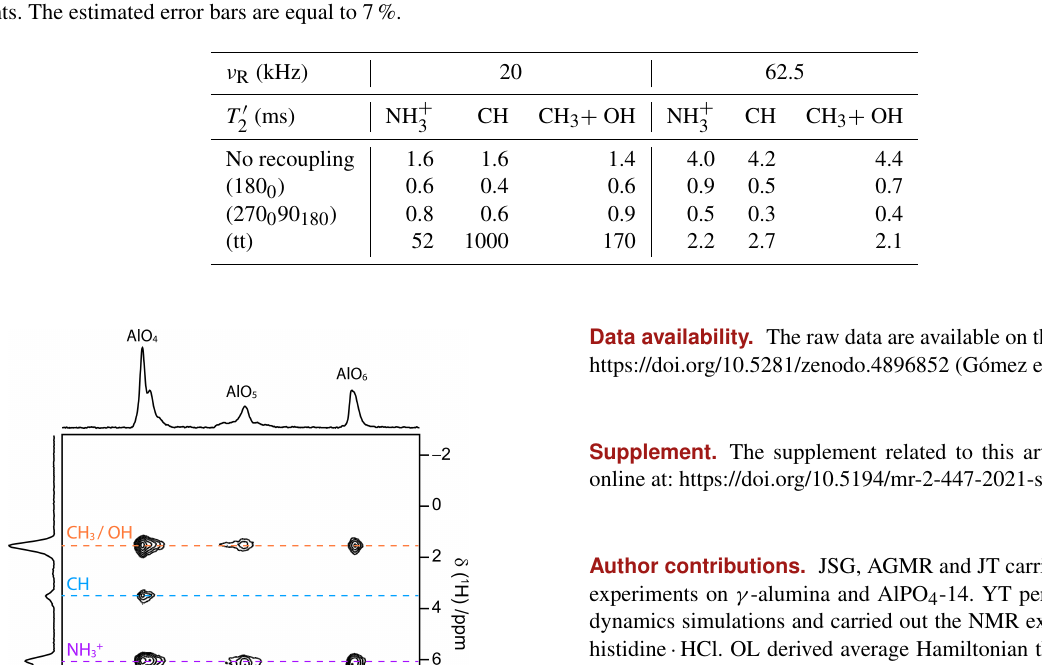
recoupling built from (180 0 ), (270 0 90 180 ) or (tt) inversion 1